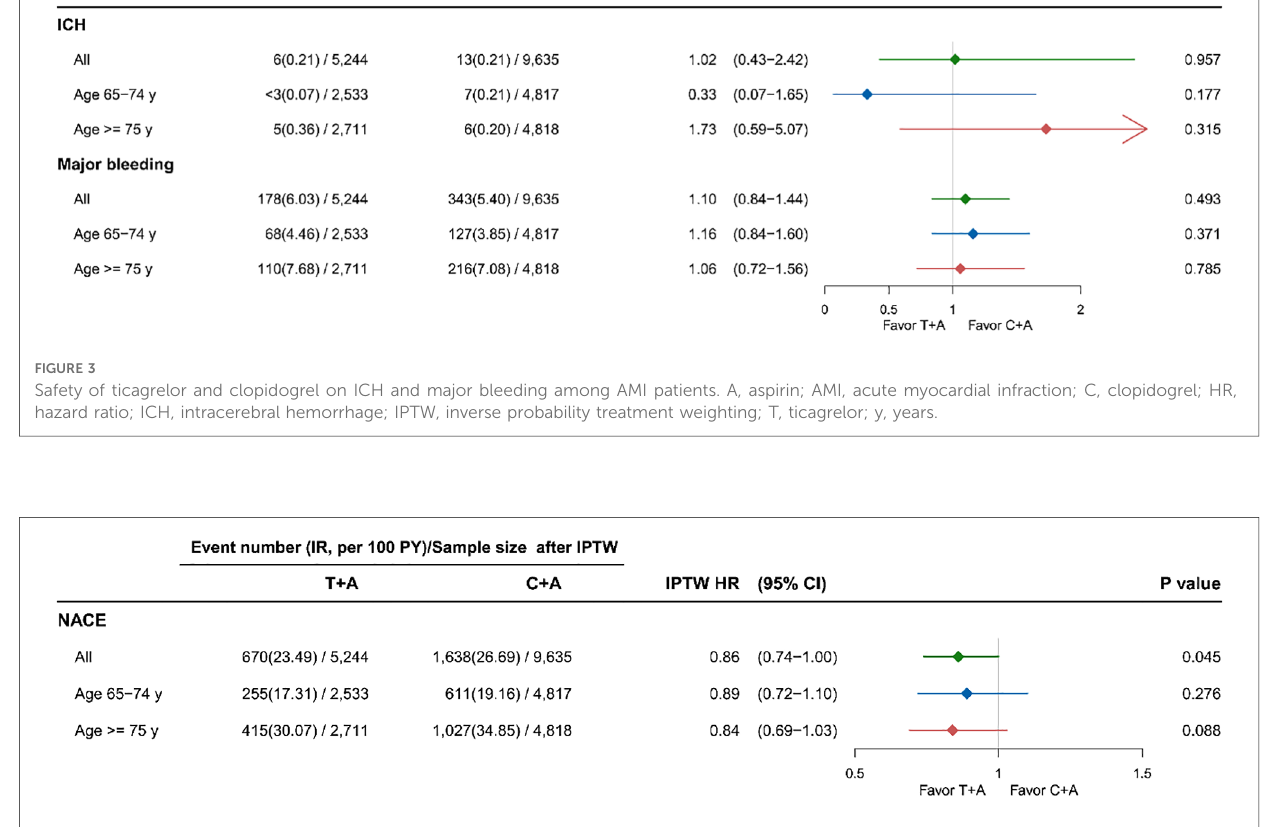
FIGURE 4 Outcome of ticagrelor and clopidogrel on NACE among AMI patients. A, aspirin; AMI, acute myocardial infraction; C, clopidogrel; HR, hazard ratio; ICH, intracerebral hemorrhage; IPTW, inverse probability treatment weighting; NACE, net adverse clinical event; STEMI, ST segment elevation myocardial infarction; T, ticagrelor; y,